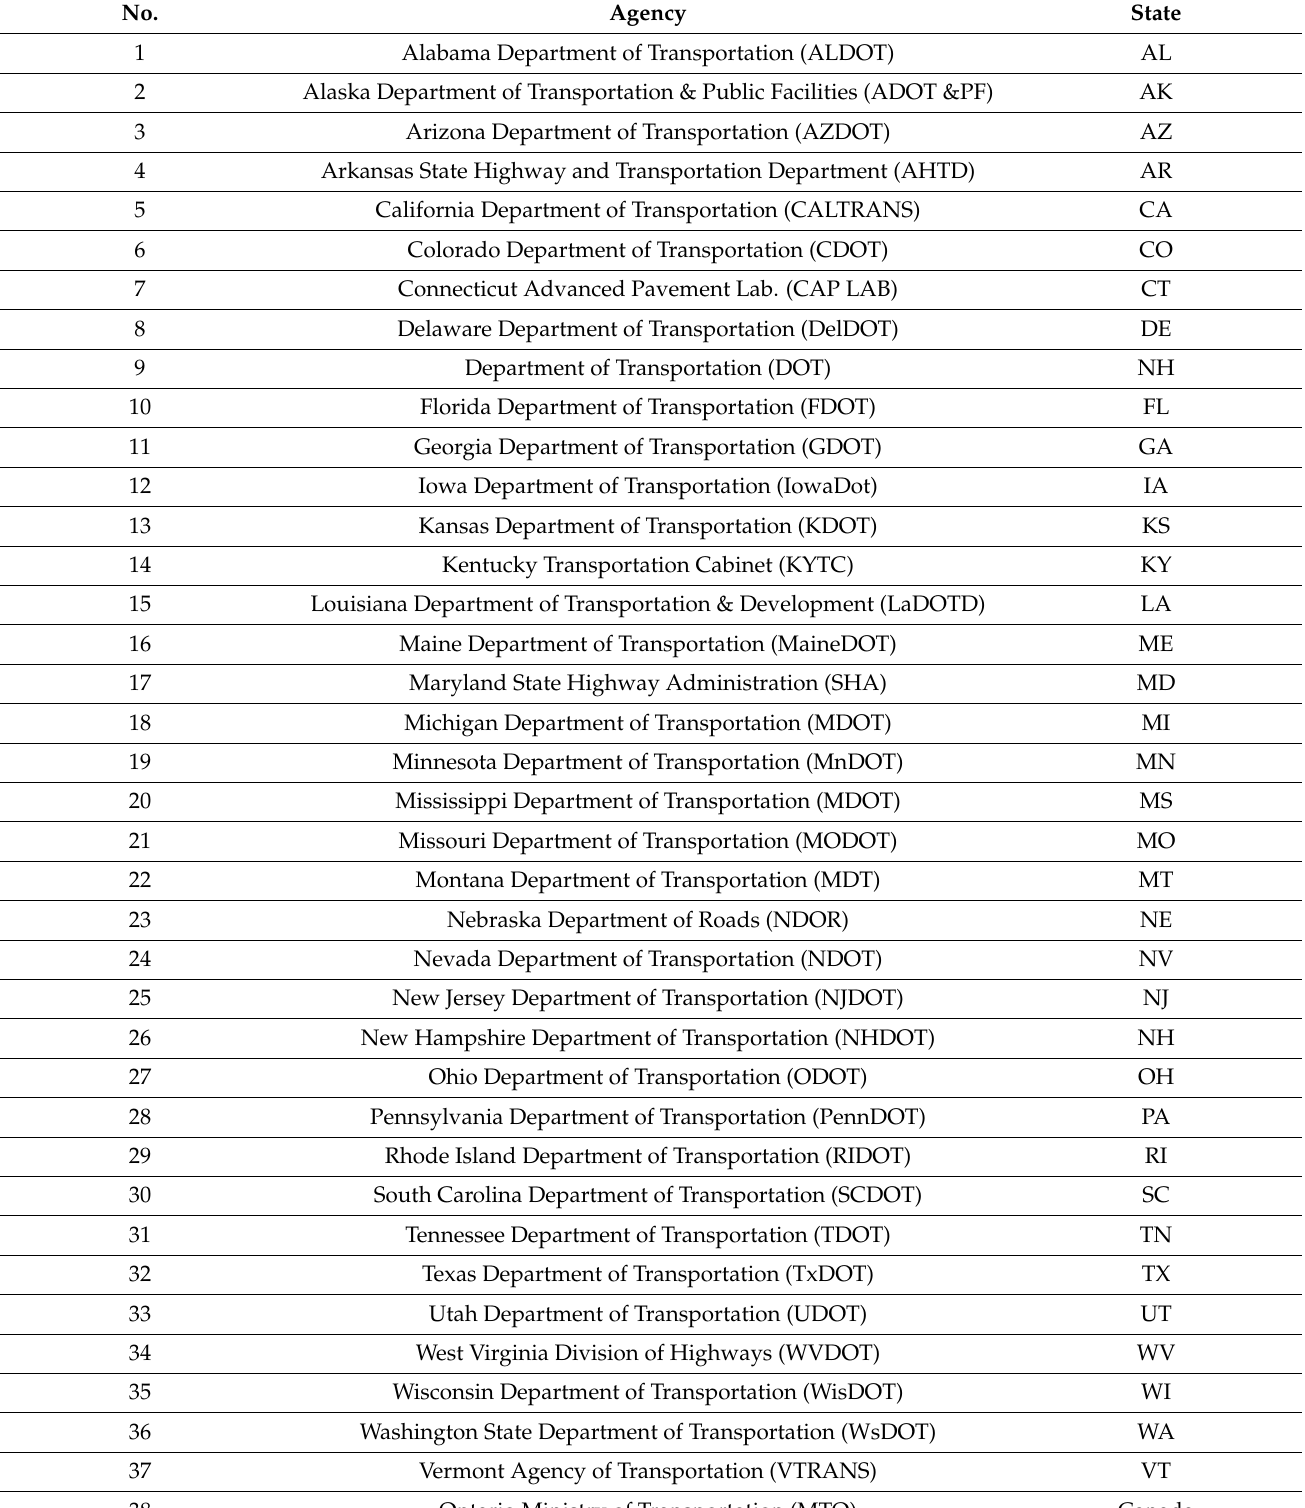
Table 8. Transportation agencies that participated in